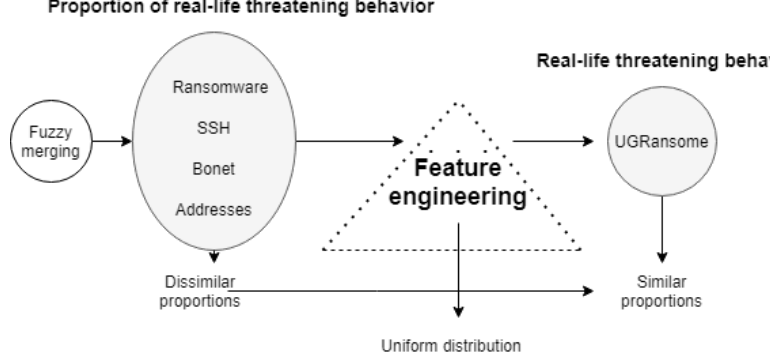
Figure 29. Achieving the dataset